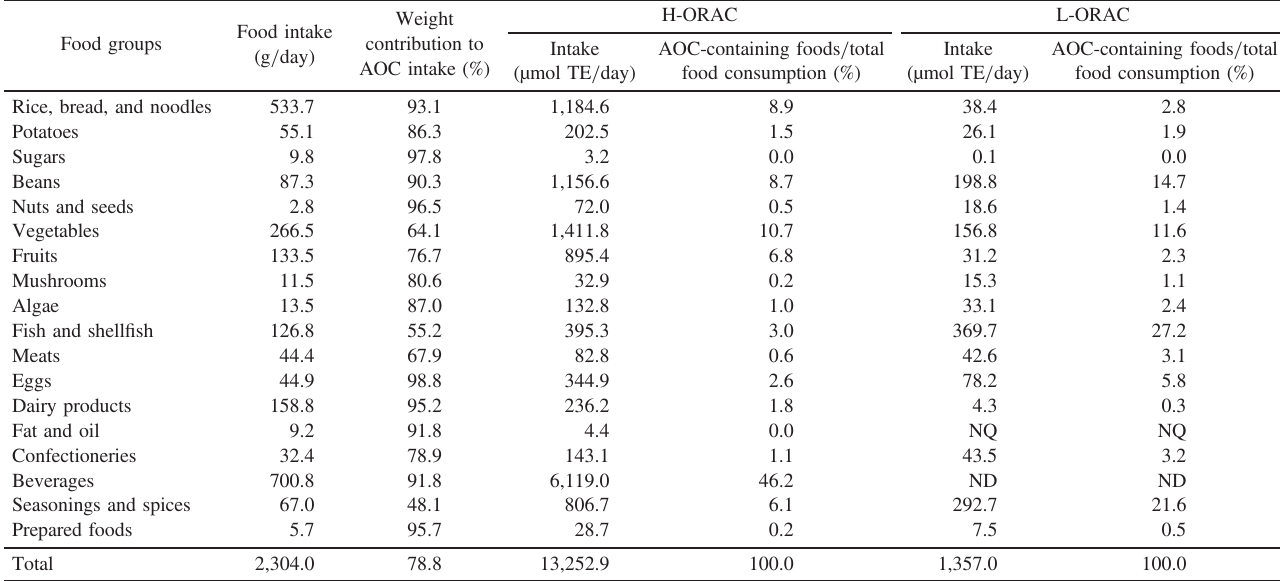
Japanese Diet and Antioxidant